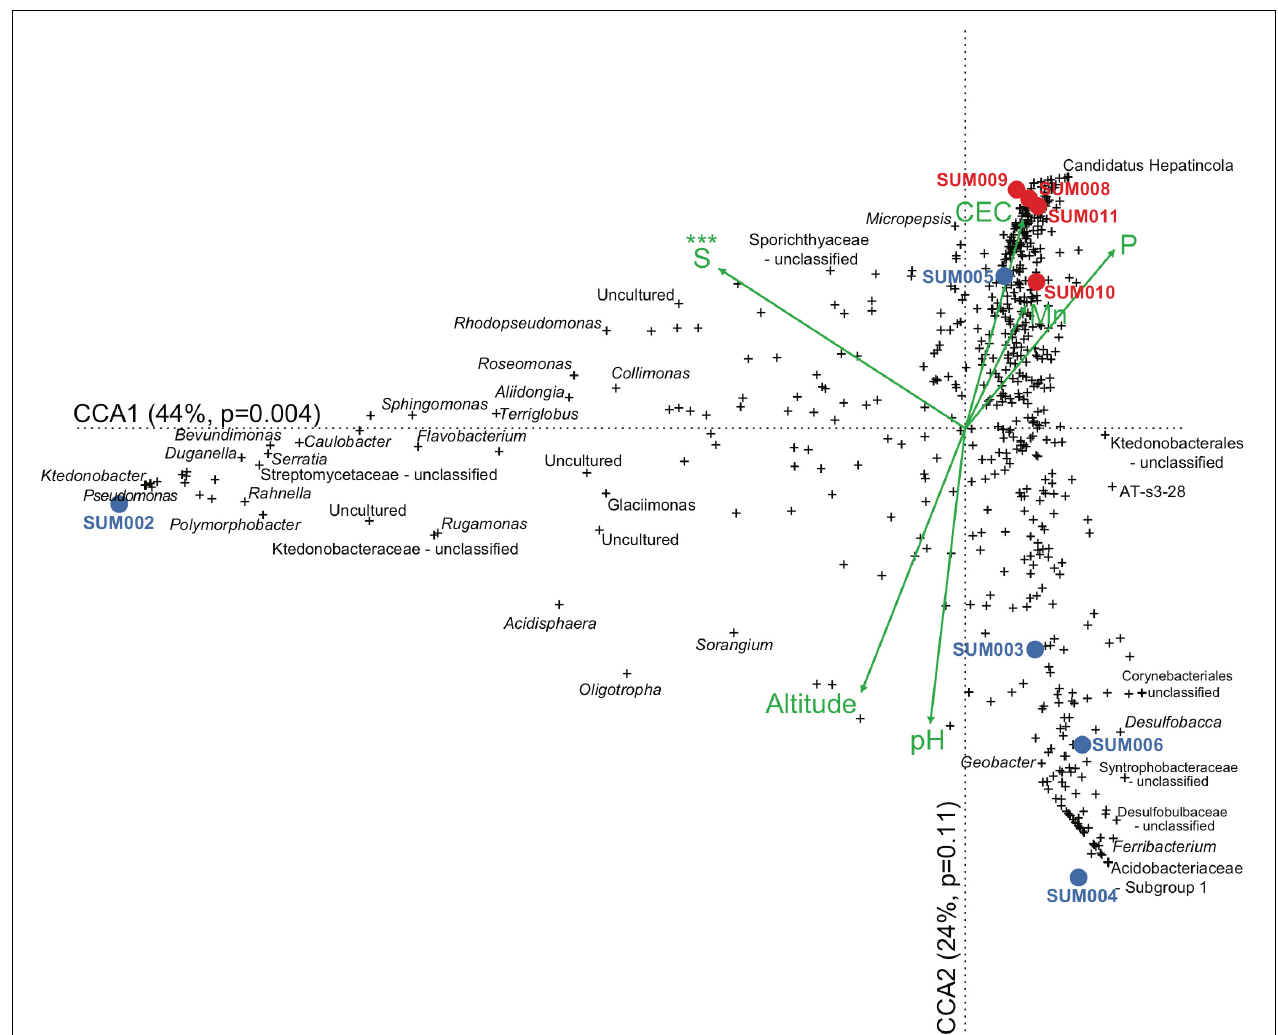
FIGURE 3 | Graphical depiction of the CCA analysis. The first two canonical axis represent 68% of the total explained variance. Environmental constraints are shown as green arrows. Blue and red dots represent high and low-altitude soil samples, respectively. Crosses represent the genera from the selected 8 most abundant phyla that represented > 90% of the relative abundances. Only the most salient genera have been annotated, as the available space precludes including the names for every sample. The three asterisks on top of sulfur, represent its significance test for the marginal effects of each environmental